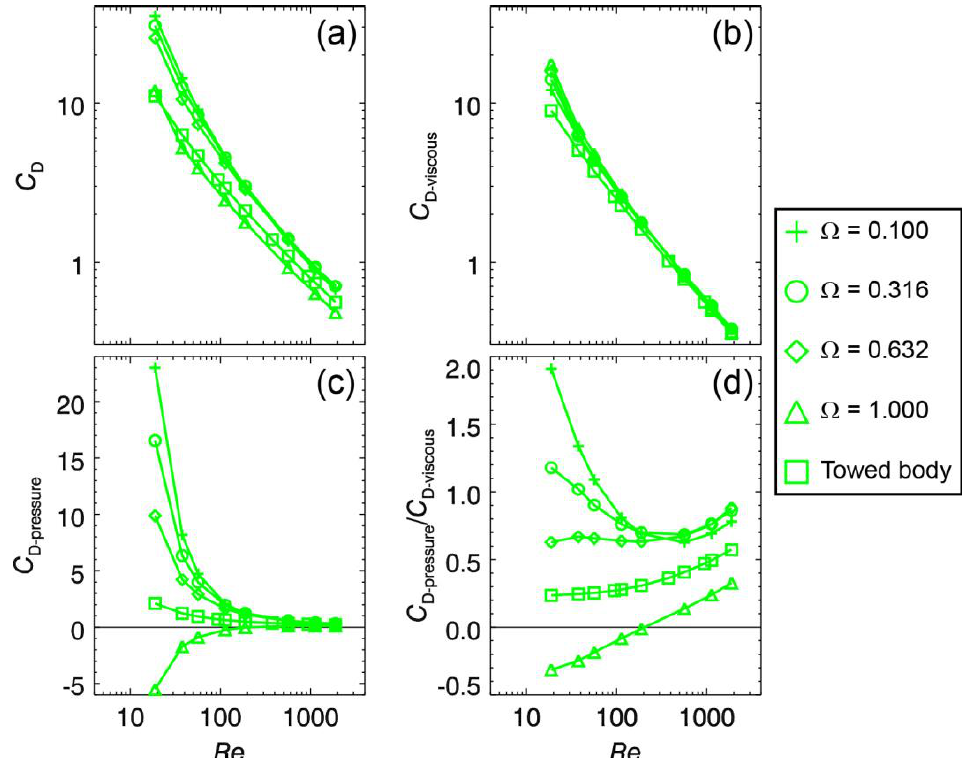
Figure 6. Line plots of ( a ) C D , ( b ) C D-viscous , ( c ) C D-pressure , and ( d ) C D-pressure / C D-viscous against Re , for the jet-propelled body R3-S (Ω = 0.100), R3-M1 (Ω = 0.316), R3-M2 (Ω = 0.632), and R3-B (Ω = 1.000), and for the towed body T3. All these bodies have the same body aspect ratio (i.e., e = 10/29).